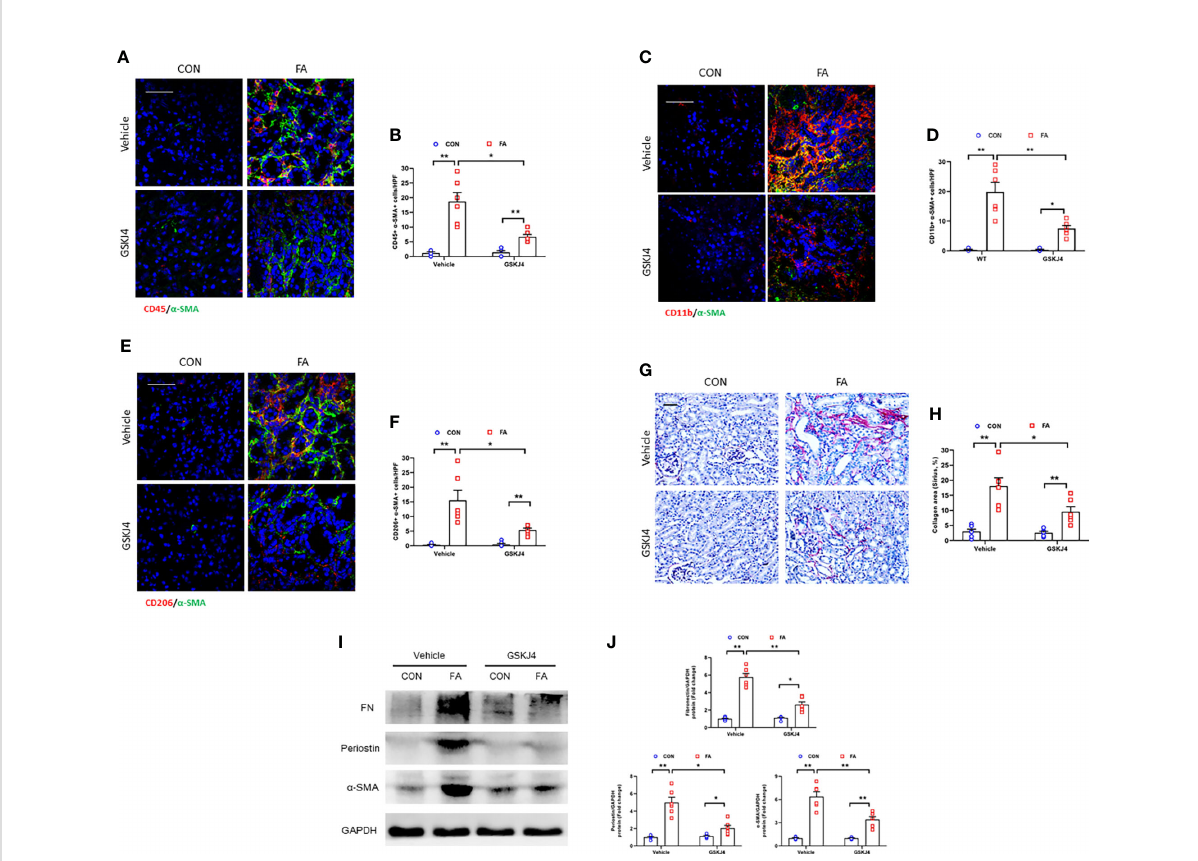
FIGURE 6 Pharmacological inhibition of Jmjd3 suppresses myeloid fi broblast activation, M2MMT, and renal fi brosis in kidneys with FA injury. (A) Kidney sections were stained for CD45 (red), and a -SMA (green). (B) Quantitative analysis of CD45 + - a -SMA + cells. (C) Kidney sections were stained for CD11b (red), and a -SMA (green). (D) Quantitative analysis of CD11b + - a -SMA + cells. (E) Kidney sections in each group were stained for CD206 (red) and a -SMA (green). (F) Quantitative analysis of CD206 + - a -SMA + cells in the kidneys. (G) Kidney sections were stained with Sirius red. (H) Quantitative analysis of collagen area. (I) Western blots bands of protein expression of fi bronectin, periostin and a -SMA in the kidneys. (J) Quantitative analysis of protein levels. * P <0.05 or ** P <0.01; n = 6; Bar = 50 m m. HPF, high-power fi